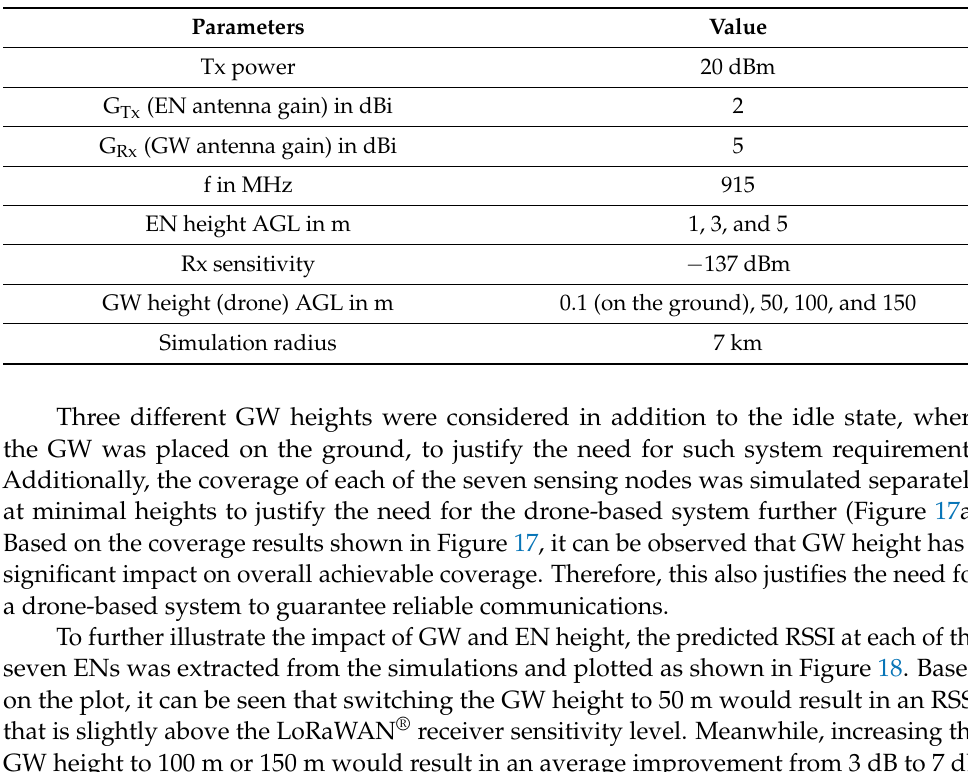
Table 5. Cloud-RF ® simulation parameters.